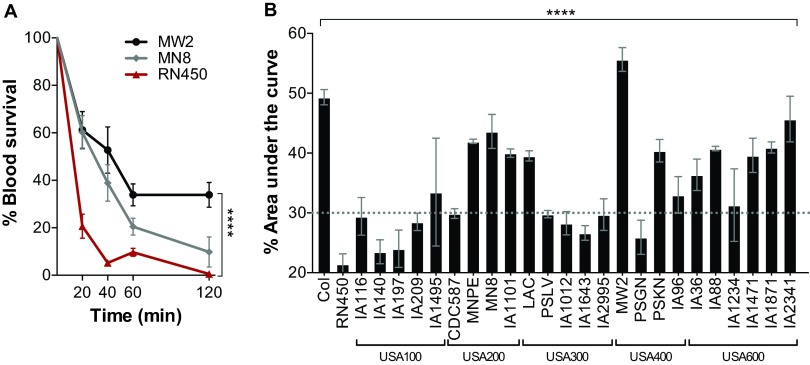
Strains in the USA200 and USA600 lineages exhibit the highest survival in blood. Freshly collected heparinized blood was inoculated with the indicated S. aureus strains at concentrations of 1 × 107 to 5 × 107 CFU/ml and incubated for a total of 120 min. S. aureus viability was determined at 0, 20, 40, 60, and 120 min. (A) Representative isolates with significantly different rates of survival in blood. Data are plotted as the percentages of viable bacteria recovered from the initial inoculum. (B) Blood survival of S. aureus isolates from multiple clonal groups. The area under each survival curve was calculated using GraphPad Prism software and plotted as the average survival for each strain. Data are plotted as the percentage of the area under the curve for each isolate. Values above the dotted line are significantly different than those below. Data are presented as mean values ± standard errors of the means. ****, P < 0.0001 by one-way ANOVA and Holm-Sidak multiple-comparison test; P values of ≤0.05 are considered statistically significant.